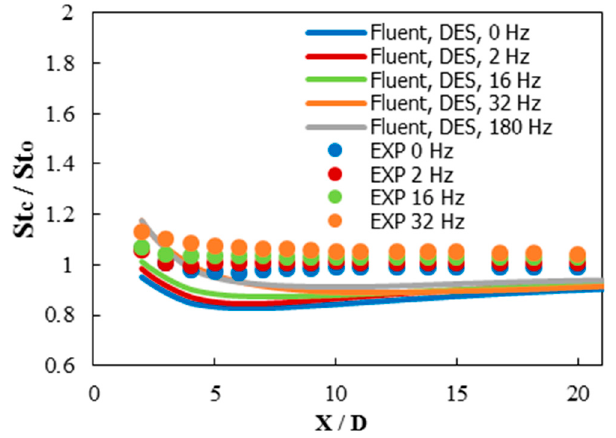
Figure 18. The centerline Stanton number ratio obtained using the DES Realizable k - ε model for M = 0.5 for the 0, 2, 16, 32, and 180 Hz oscillations. Inventions 2018 , 3 , x FOR PEER REVIEW 19 of 33